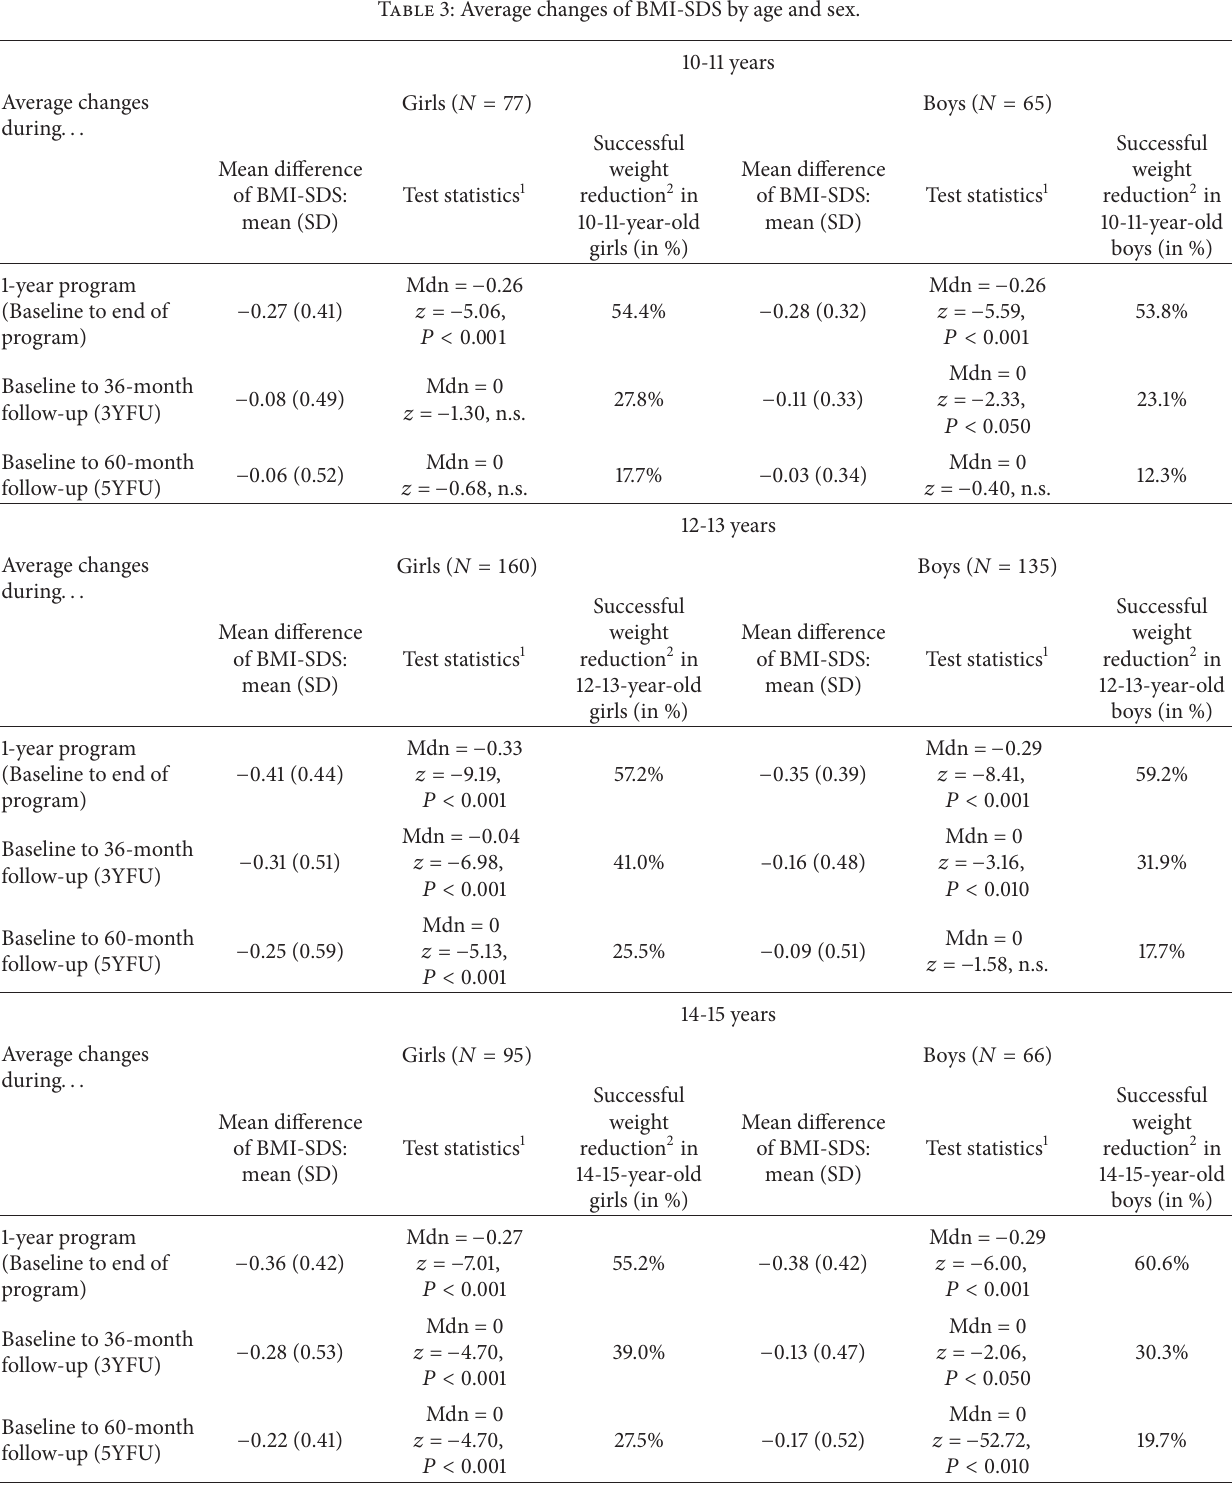
Table 3: Average changes of BMI-SDS by age and